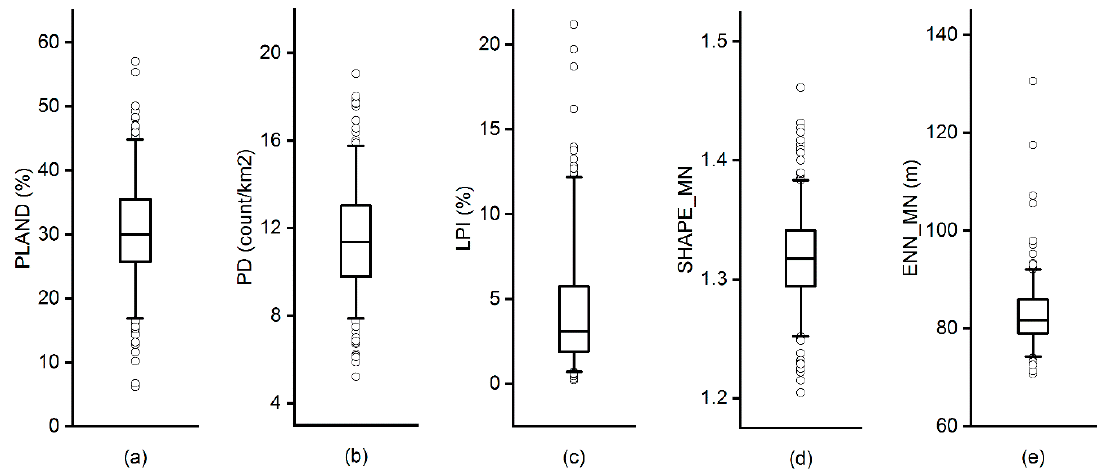
Figure 2. Summary statistics of landscape metrics of urban green spaces, ( a ) percentage of landscape, ( b ) patch density, ( c ) largest patch index, ( d ) mean patch shape index, and ( e ) mean Euclidian nearest neighbor distance. The box shows median, 25th and 75th percentile, and the whiskers illustrate the 5th and 95th percentile values.